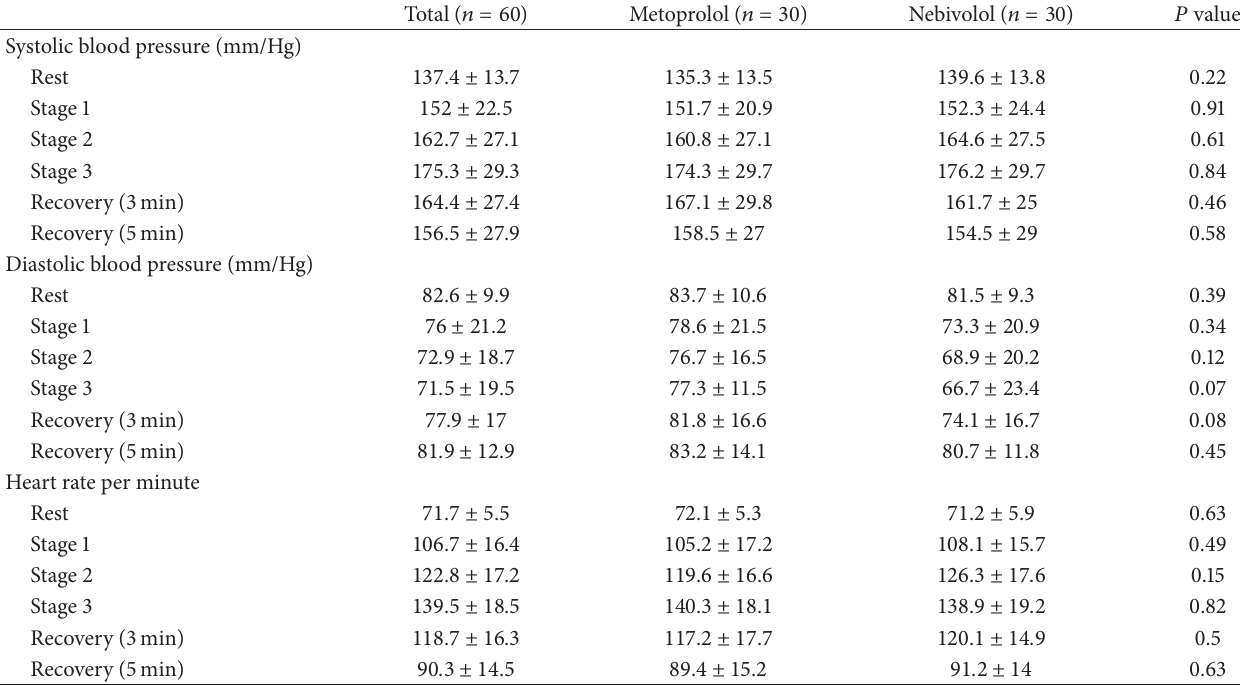
Table 3: The values of blood pressures and heart rates measured during rest, exercise, and recovery periods in the study population.